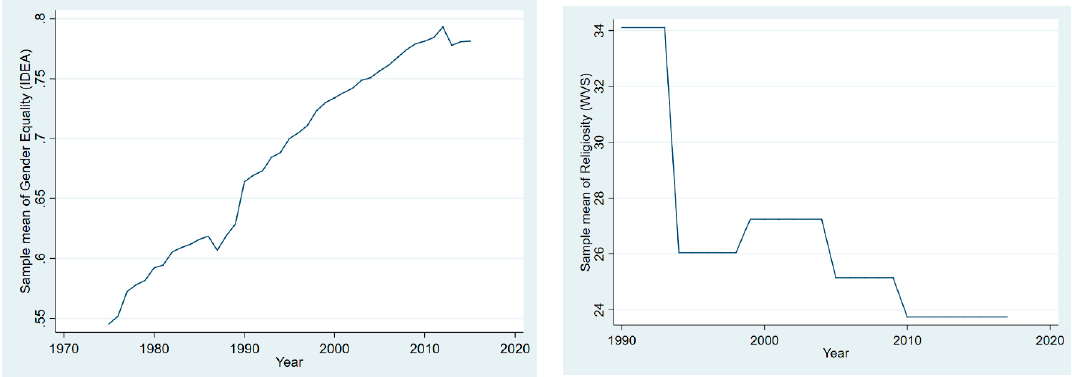
Figure A2. Evolution of Gender Equality and Religiosity.